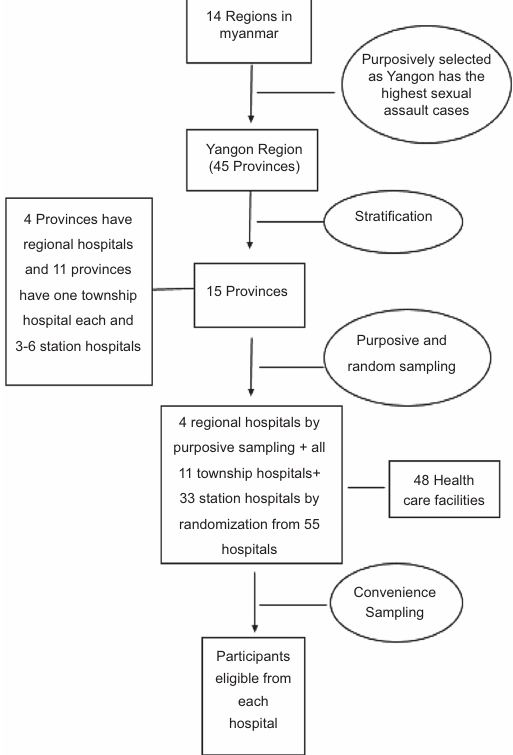
Figure 1. Flow chart of sampling